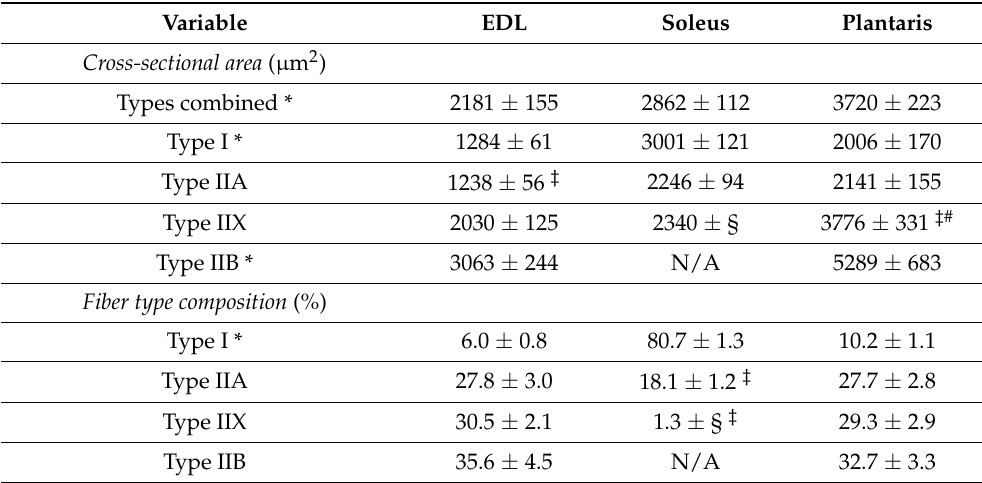
Table 3. Myofiber